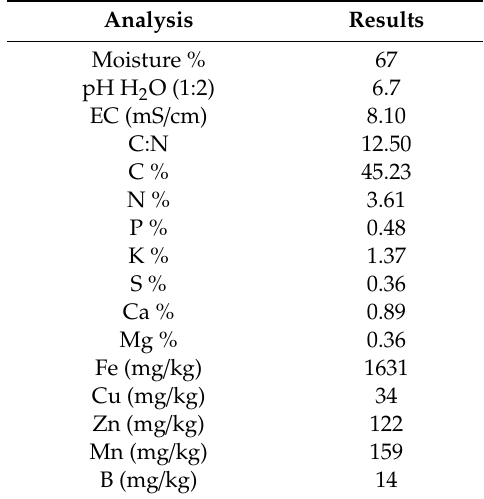
Table 6. Chemical analysis of the terra preta sanitation